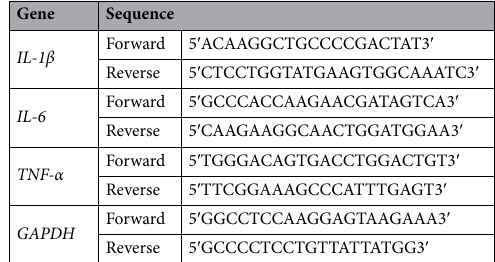
Table 4. Quantitative real time PCR primer